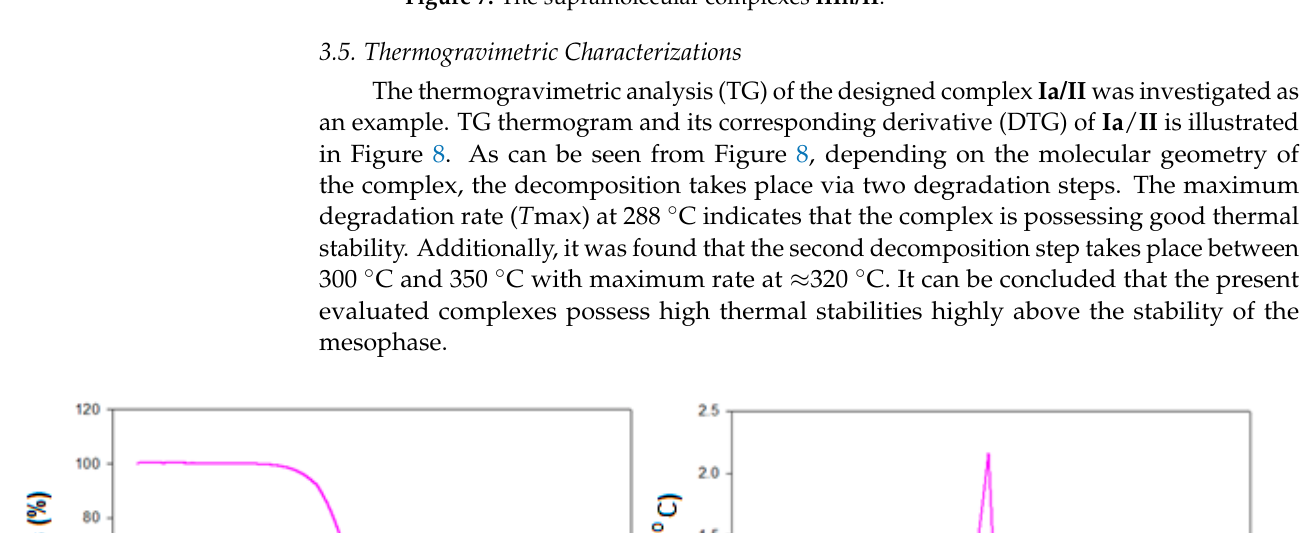
Figure 7. The supramolecular complexes IIIn/II.